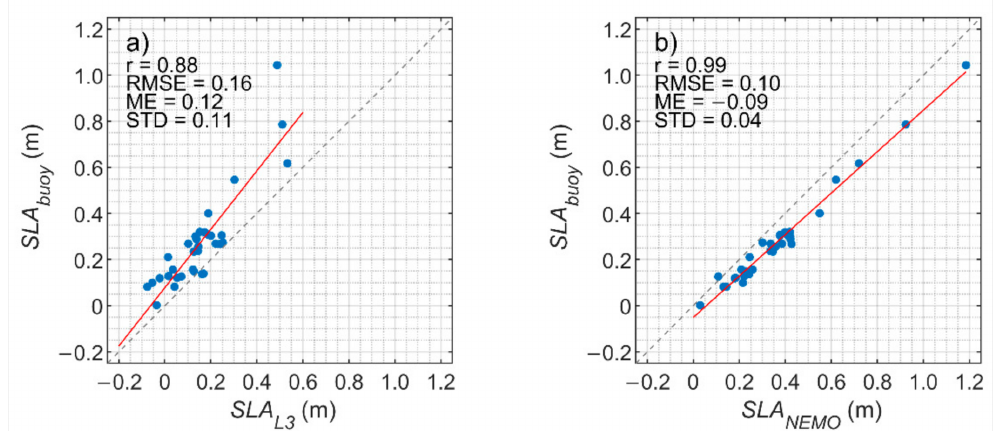
Figure 12. Comparison of buoy-based sea-level measurements ( SLA buoy ) with ( a ) altimetry CMEMS Level 3 sea-level anomaly ( SLA L3 ) and ( b ) NEMO reanalysis model ( SLA NEMO ) in the Gulf of Riga (green circle in Figure 2). The red line is the linear regression between the two